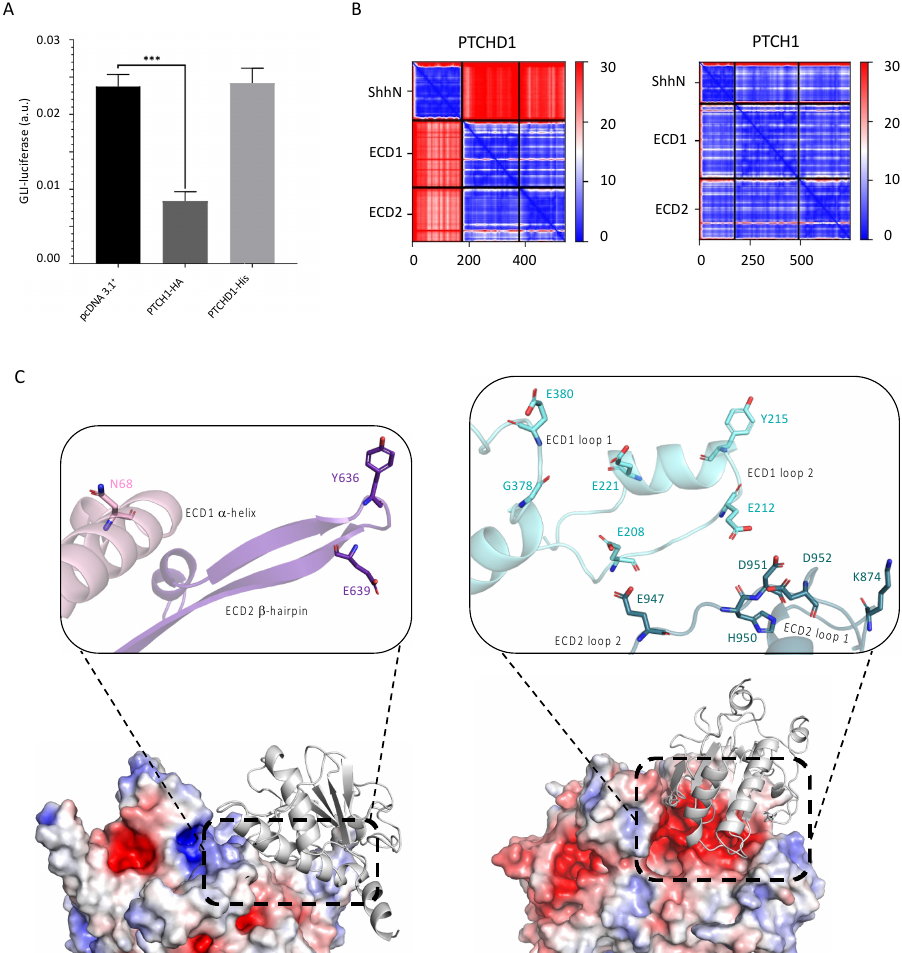
Figure 6. PTCHD1 does not inhibit Hh pathway activation nor bind ShhN. ( A ) A GLI ‐ luciferase assay of Ptch1 ‐ / ‐ MEFs shows transient transfection with PTCH1 ‐ HA leads to a significant (65%) inhibition of the Hh pathway (*** p < 0.001), while the level of GLI-luciferase expression remains unchanged in cells transfected with PTCHD1-His or empty plasmid (pcDNA3.1 + ). ( B ) Figures depicting the predicted aligned error between residues show high error rate (red) in predicted complex formation between ShhN and PTCHD1 ECDs, while the estimated error is low (blue) between the two ECDs. On the other hand, the predicted error is low between ShhN and PTCH1 ECDs. ( C ) AlphaFold2 predicted complexes of PTCHD1 ECD1:ECD2:ShhN (left) and PTCH1 ECD1:ECD2:ShhN (right). Insets show close ‐ ups of the secondary structures and hydrogen ‐ bond forming residues involved in ShhN binding.